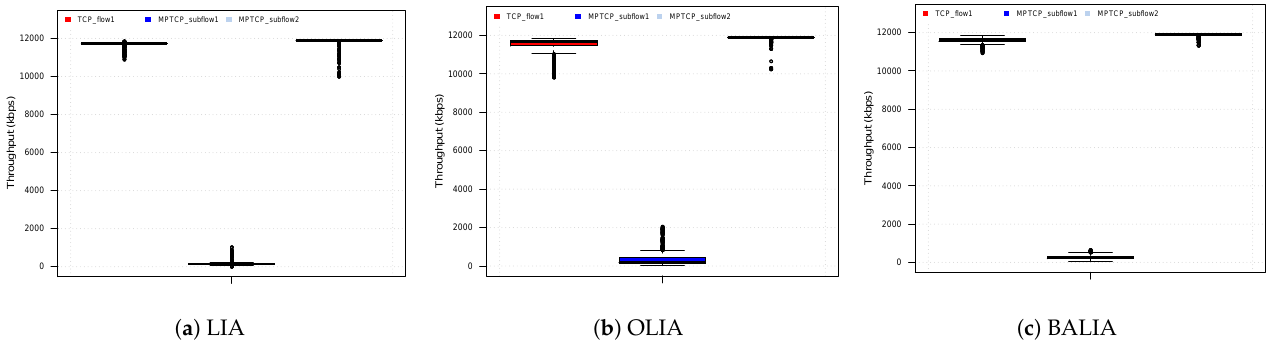
Figure 19. LIA, OLIA and BALIA Throughput Share—Disjoint Paths with RTT1 = 50 ms and RTT2 = 150 ms.